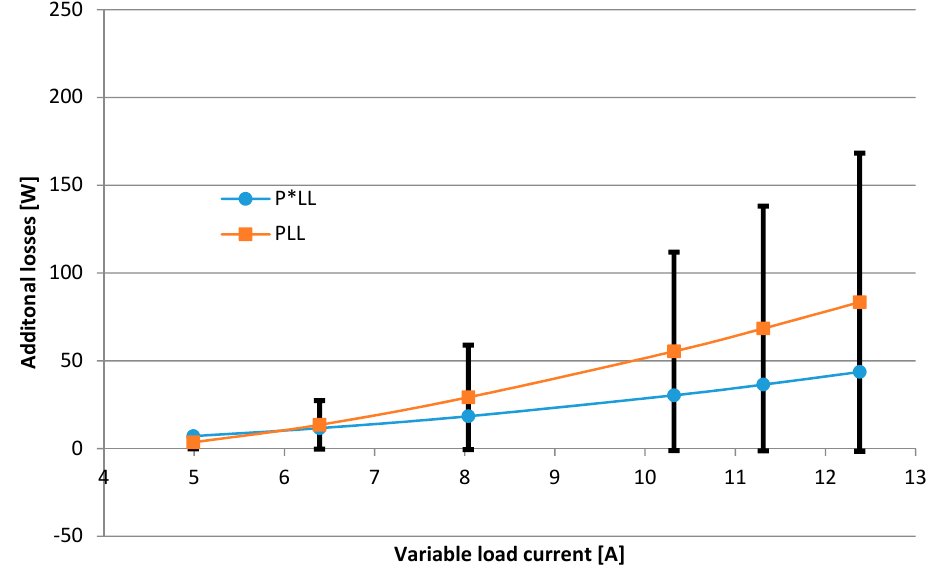
Figure 2. Comparison among the additional losses, with the extended uncertainties.